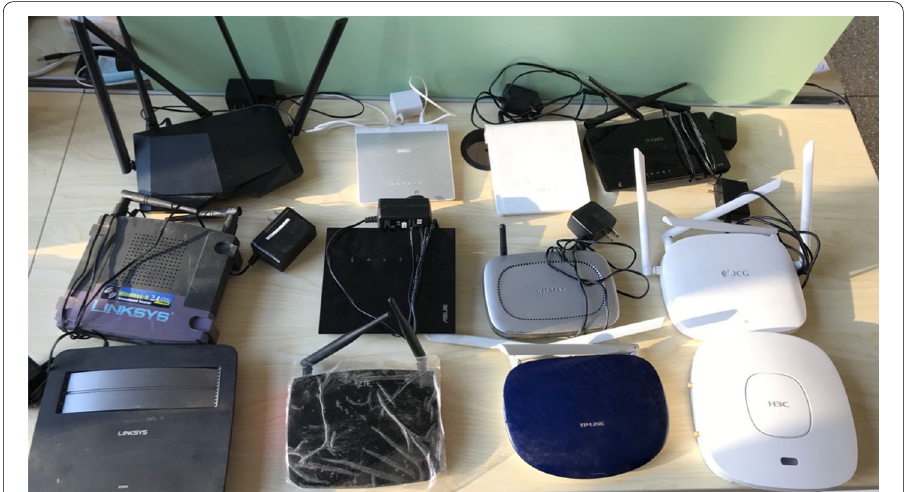
Fig. 8 Part of the devices used in the